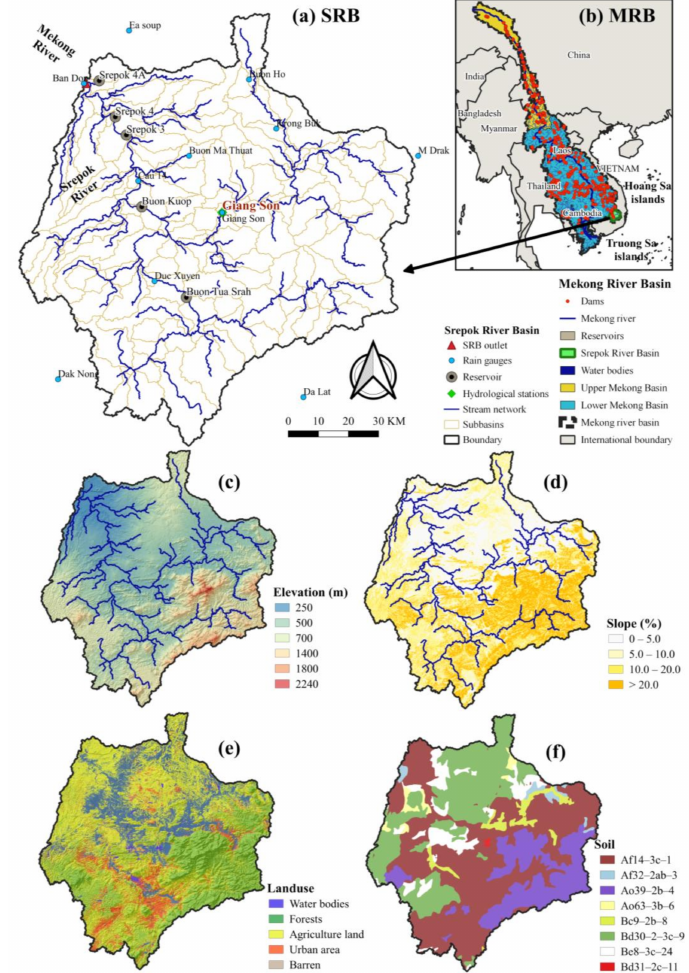
Figure 1. Maps of ( a ) SRB, ( b ) MRB, ( c ) DEM, ( d ) slope, ( e ) land–use, and ( f )